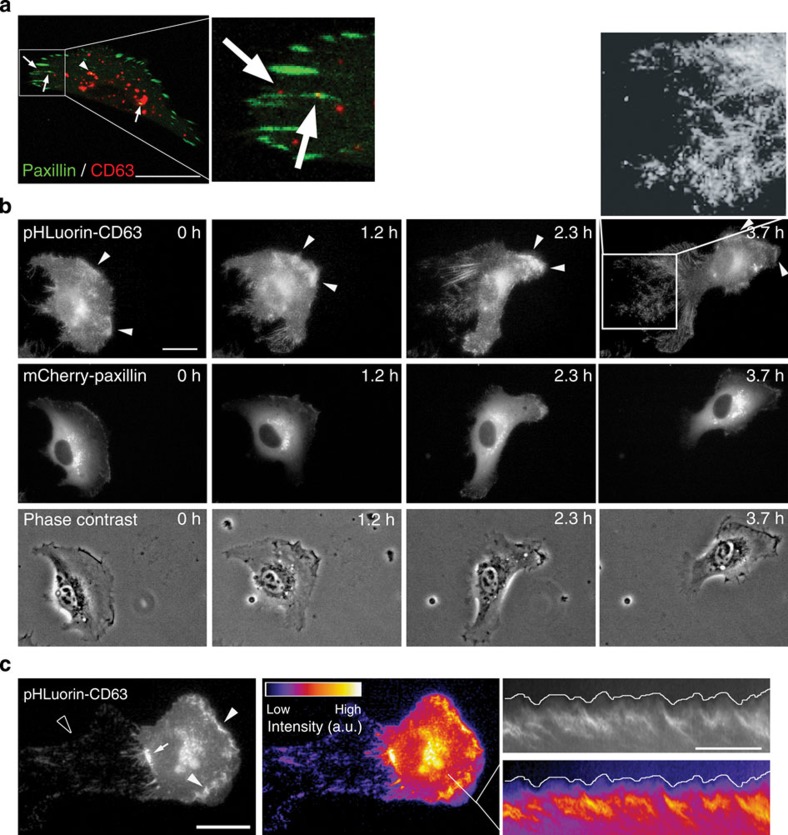
Adhesive exosome trails are left behind migrating cells(a) Confocal image of mCherry-CD63 (red) and GFP-paxillin (green)-expressing HT1080 cell from a representative movie from n=17 movies on FN-coated (1 μg ml−1) MatTek dishes. Arrows indicate co-localization of mCherry-CD63 with adhesions, whereas an arrowhead indicates localization of paxillin within endosomes. Magnification of boxed area is shown right. See also Supplementary Movie 5. (b) Image series from a representative epifluorescence movie (1 frame per 2 min, from n=10 movies) of a migrating HT1080 cell on FN-coated (1 μg ml−1) MatTek dishes transiently transfected with pHLuorin-CD63 to show sites of exosome secretion. Note CD63 fluorescence in ruffles at the front of the cell (arrowheads) and in an adhesive trail left behind the cell. Zoom is brightened and shows adhesive trail. See also Supplementary Movie 6. (c) Image from a representative epifluorescence movie with a rapid frame rate (1 frame per 6 s, from n=20 movies) to capture the dynamics of pHLuorin-CD63 in protrusions. Filled arrowheads indicate fluorescence in ruffles, whereas open arrowhead points to adhesive trail. The arrow points to rear fluorescence near retracting fibres. Heat map-coloured intensity is shown right. Grayscale and coloured kymographs show protrusion over time across the perpendicular line drawn in heat map image. Note lack of enhanced fluorescence at flat protrusion membrane edge, which is outlined by drawn white lines. See also Supplementary Movie 7. Scale bars, 30 μm.